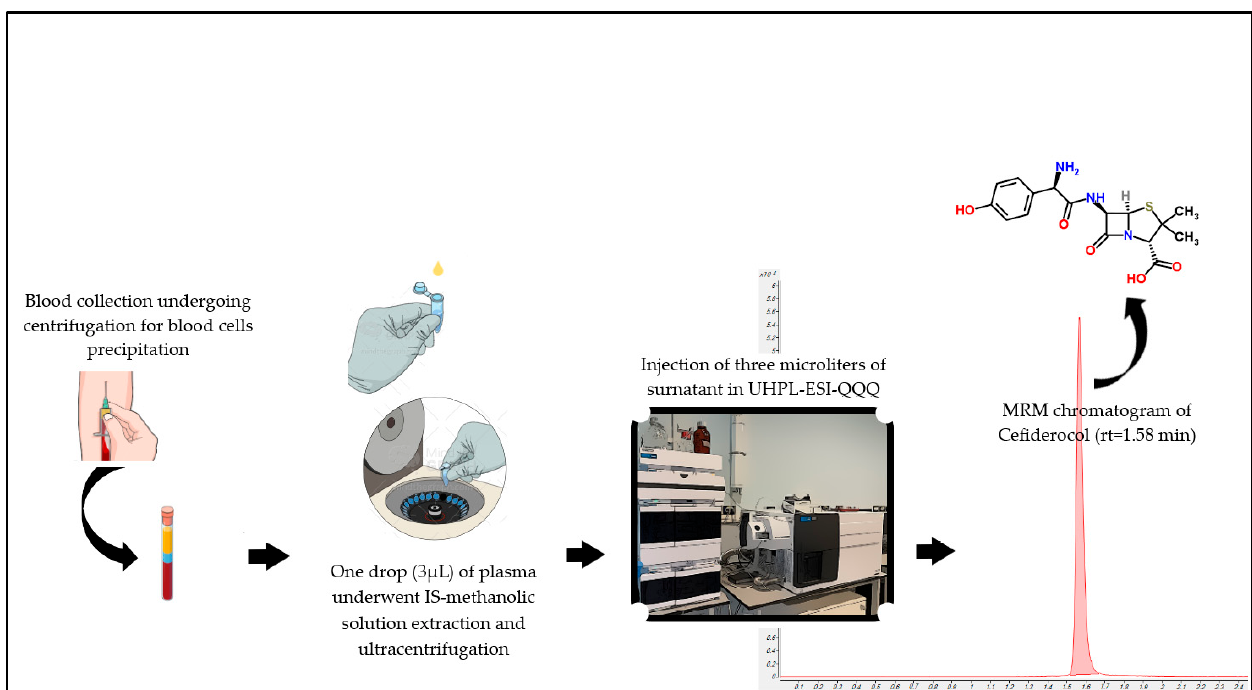
Figure 1. Cartoon depicting the analytical workflow employed in the analysis of Cefiderocol (chemical structure on the upper right corner) starting from a small plasma droplet obtained by centrifugation of whole blood.